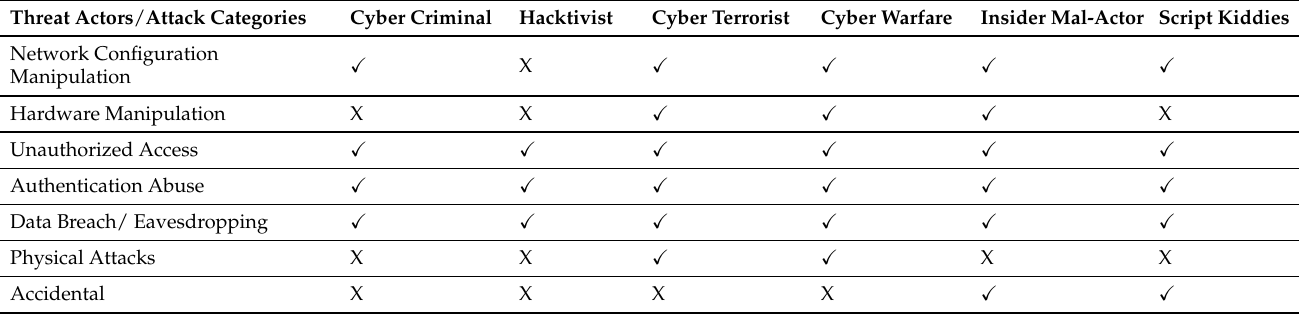
Table 3. Threat categories mapped with threat